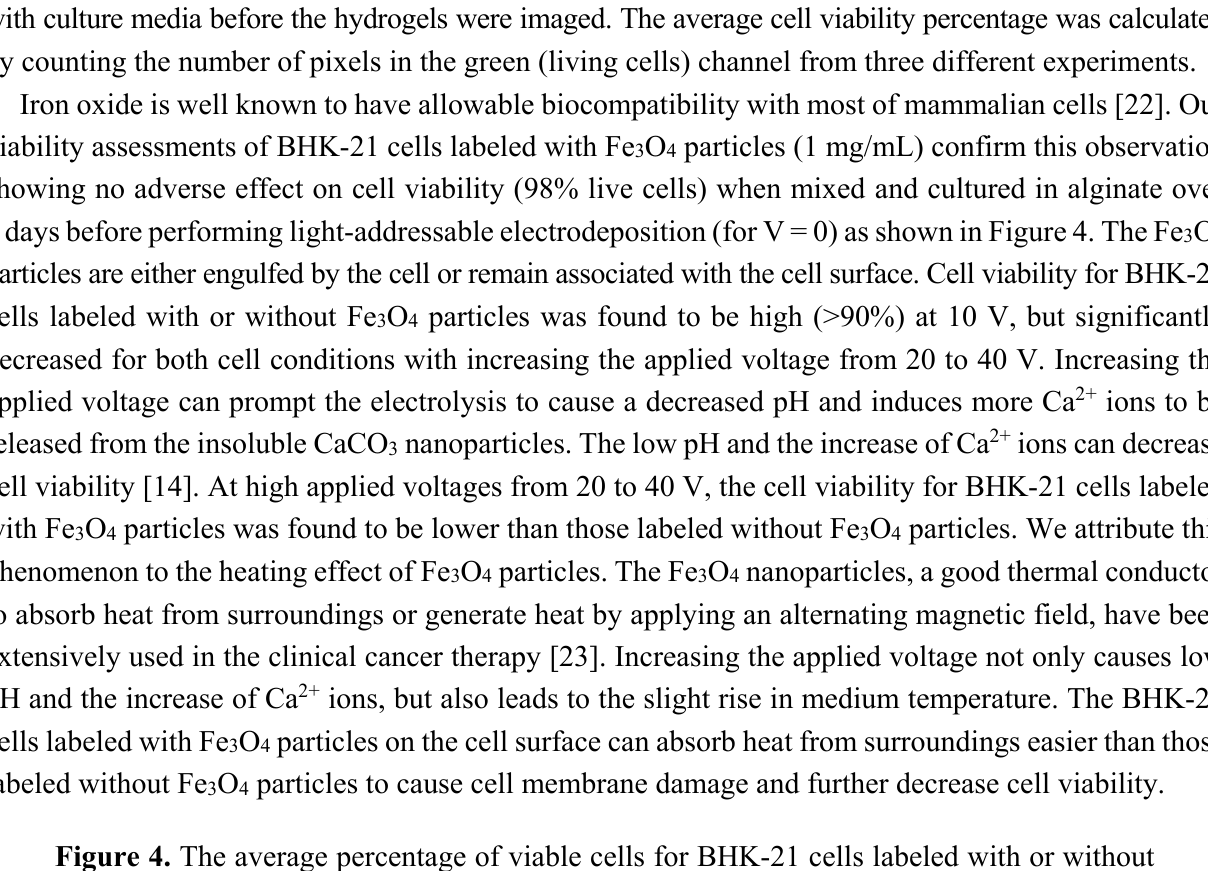
Figure 4. The average percentage of viable cells for BHK-21 cells labeled with or without Fe 3 O 4 particles inside alginate hydrogels after performing light-addressable electrodeposition at applied voltages of 0–40 for 15